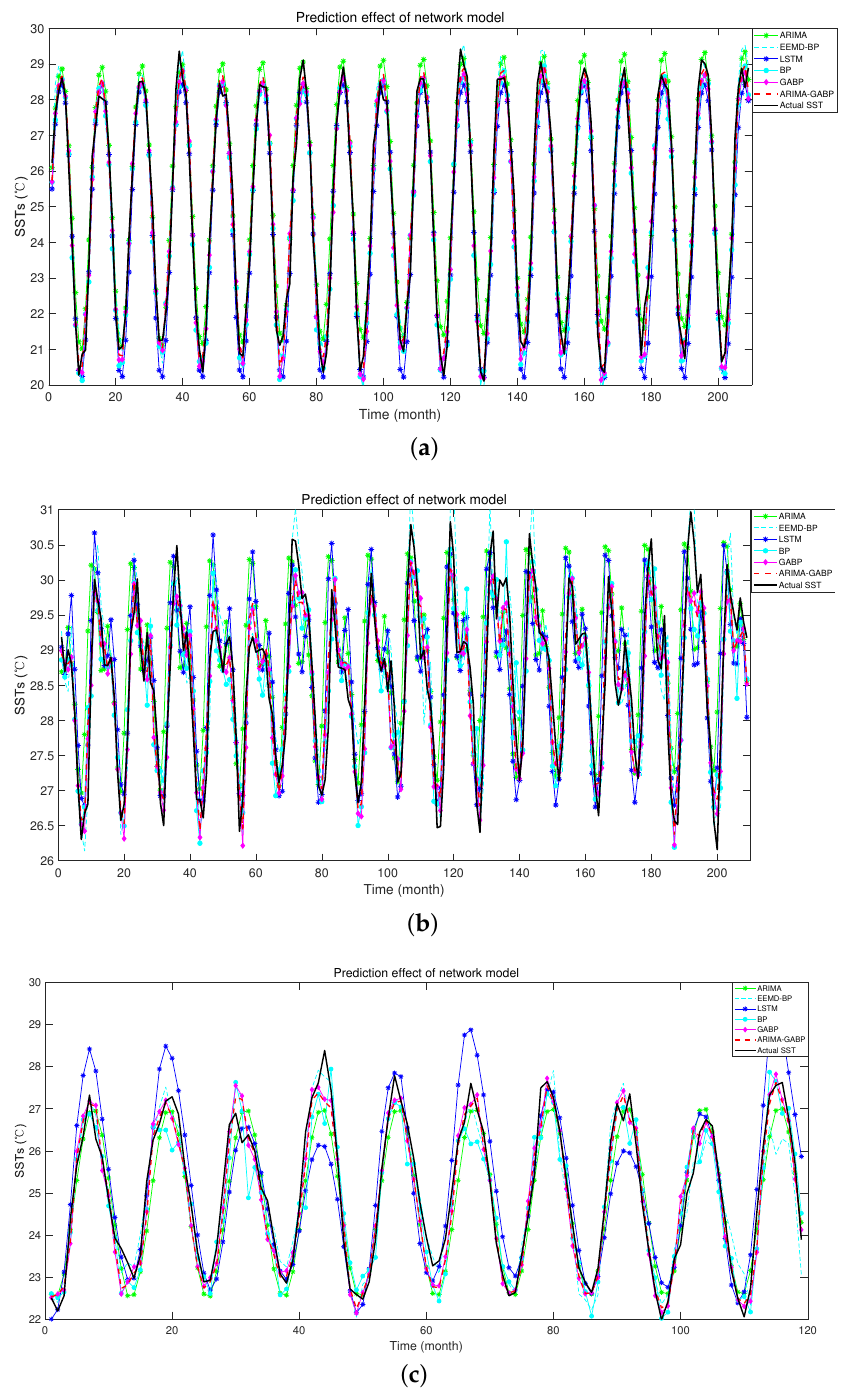
Figure 9. The predicted SSTs synthesized by various methods versus ground-truth SSTs. ( a ) The stimulative results with D 1. ( b ) The stimulative results with D 2. ( c ) The stimulative results with D